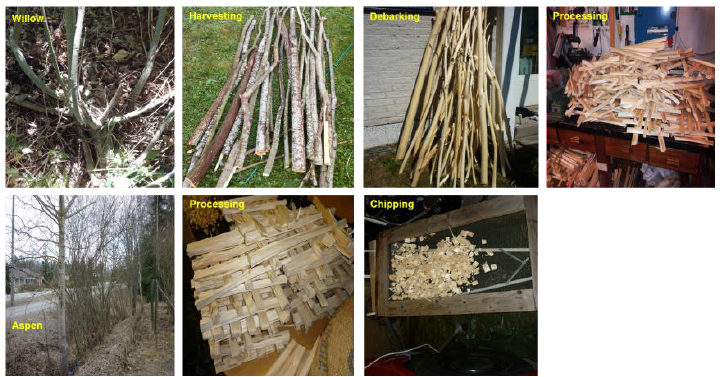
Figure 1. Harvesting and chipping process of short-rotation aspen and willow.